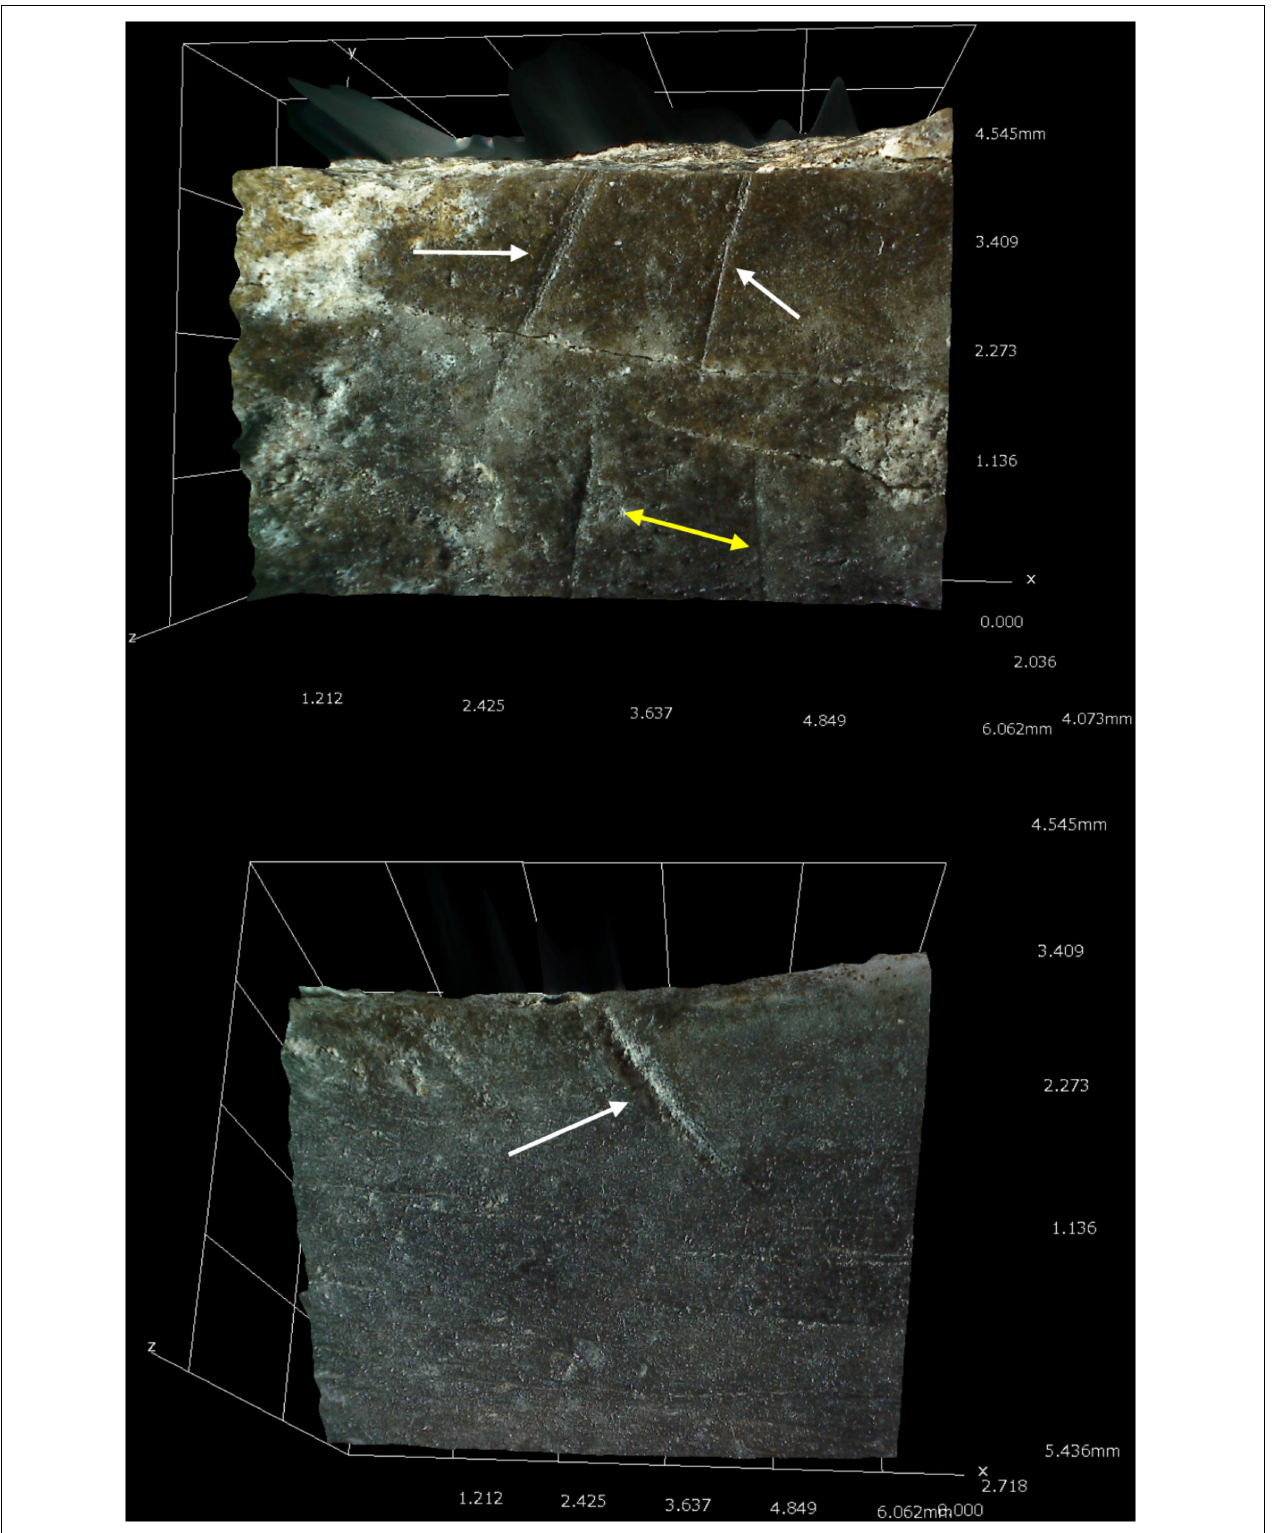
FIGURE 5 | Two cut marks from two specimens recorded in the Ewass Oldupa assemblage. (Top) Cut marks (with white arrows) and scores (yellow double arrow) on long bone fragment. (Bottom) Cut mark (white arrow) on rib shaft fragment. Measurements in mm on X - and Y -axis.